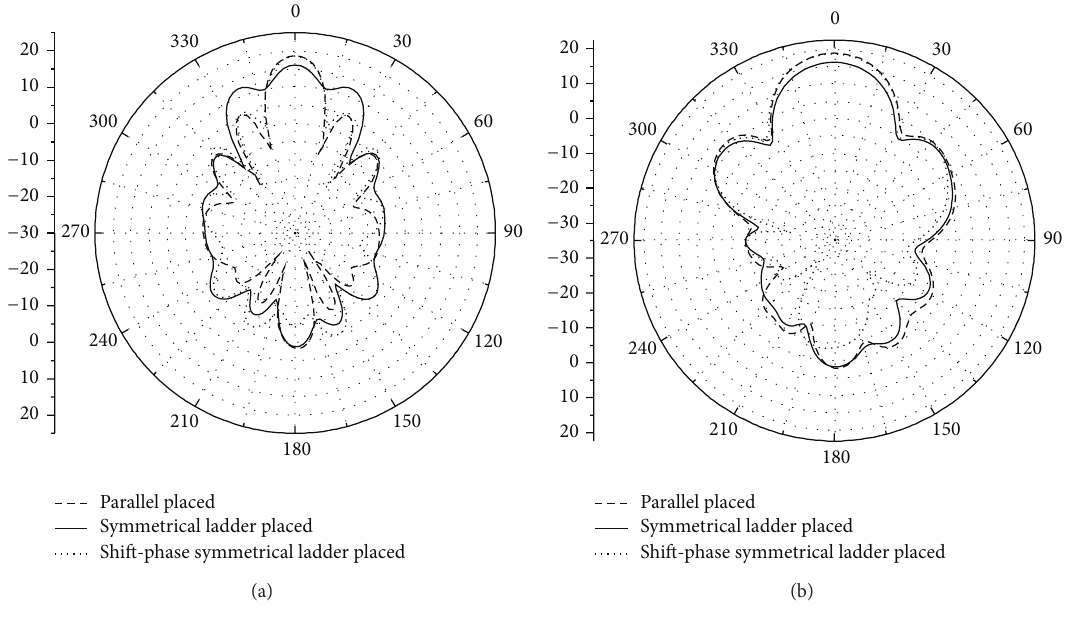
Figure 10: Pattern of 10GHz. (a) E-plane pattern of 3 × 7 unit array. (b) H-plane pattern of 3 × 7 unit array.